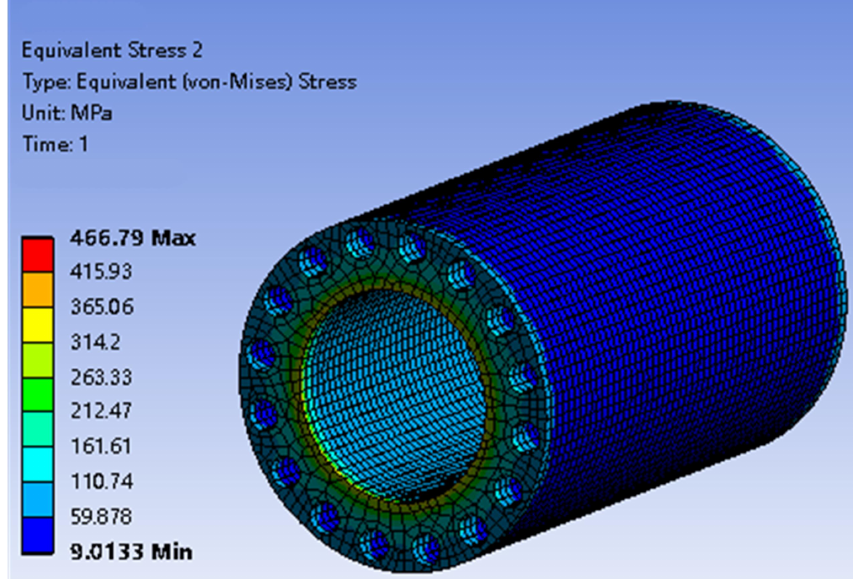
Figure 14. Maximum Mechanical Stress of the Laminated Rotor.